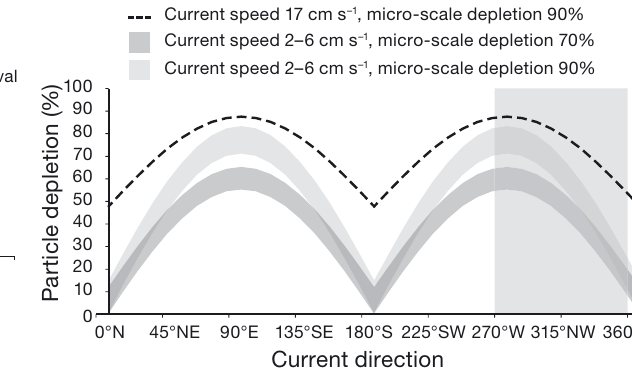
Fig. 10. Particle depletion as a function of different current directions. Micro-scale depletion value is percentage of out- side chlorophyll concentration. Grey shaded area: the span of current directions during the campaign